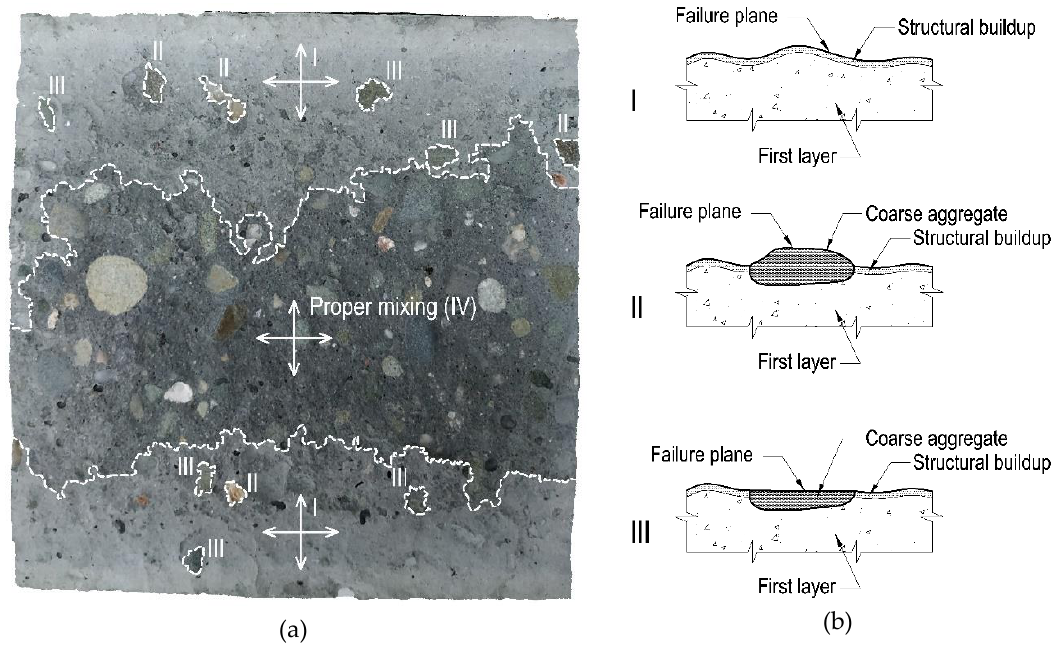
Figure 7. The surface of the first layer of a sample made with Variant A placement technology with a 60 min delay time between layers after a splitting tensile strength test: ( a ) Marked surfaces of various failure mechanisms; ( b ) description of the failure mechanism.